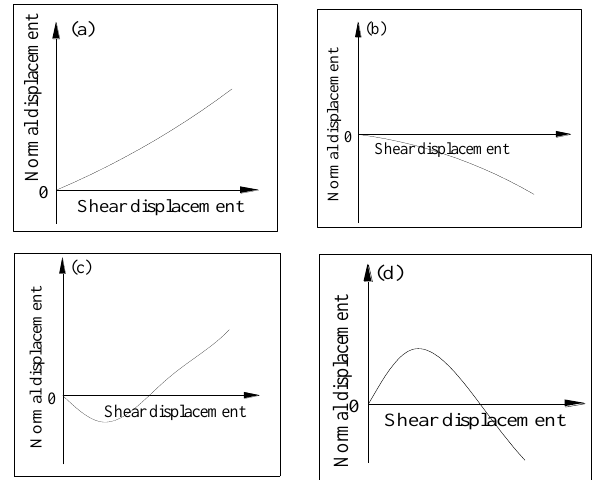
Fig.6. Shear dilatation modes of joints: (a) pure shear dilatation; (b) pure shear compression; (c) shear compression-shear dilation; and (d) shear dilation-shear compression.